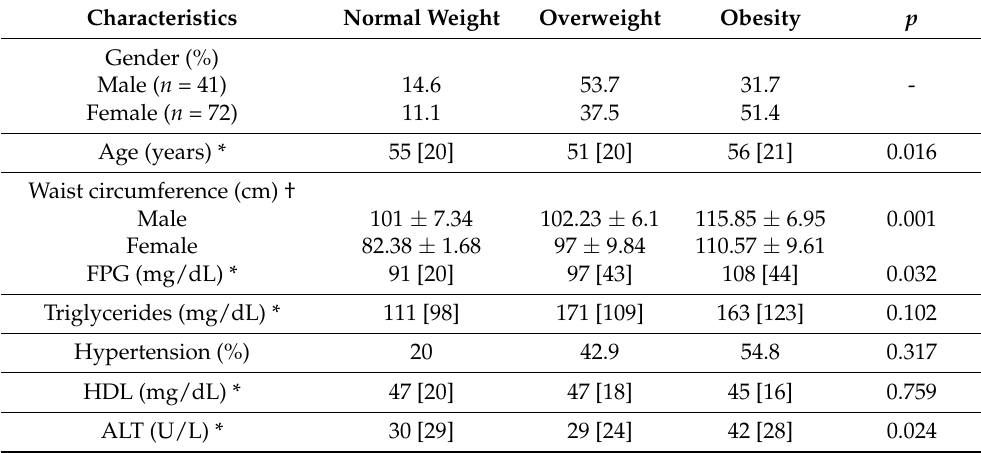
Table 1. Characteristics of the study patients.